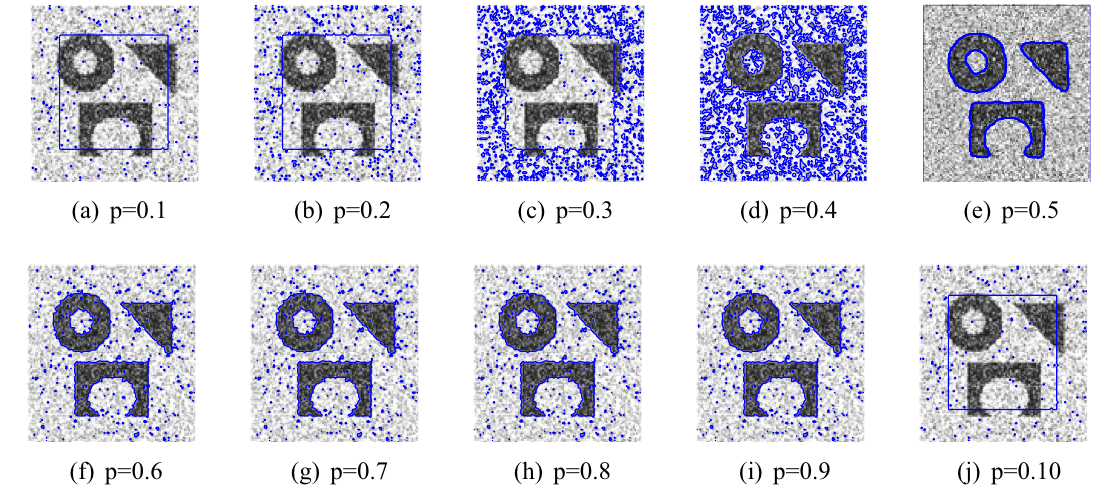
Figure 3. The performance of the proposed method for noisy image taken from 31,36 papers for different values of p , and fixed µ =0.7, σ =3, iteration = 50 .